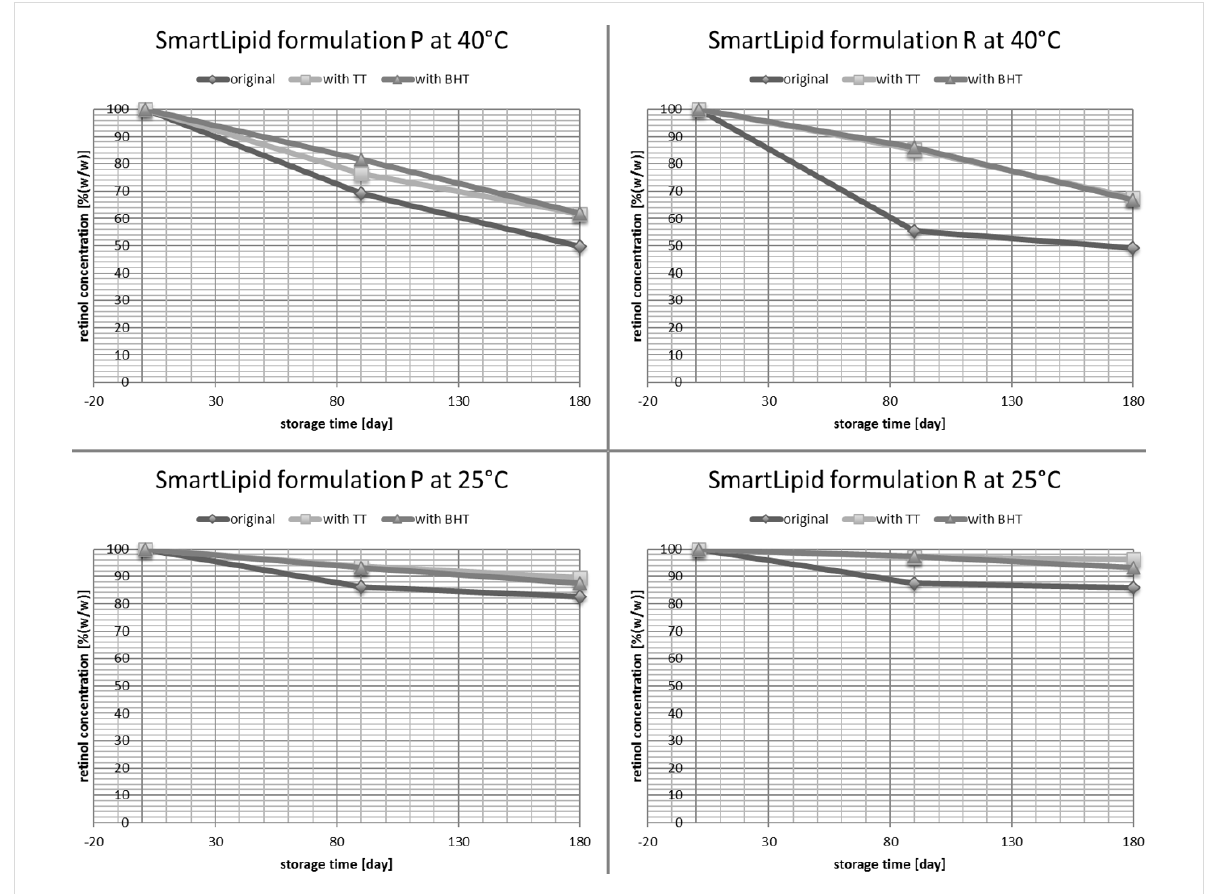
Figure 5: Storage study with retinol loaded SmartLipids particles over six months. Remaining retinol content in SmartLipids formulation P (left) and R (right) before and after incorporation of lipophilic antioxidants Tinogard TT and BHT at 40°C (upper) and room temperature (25°C, lower), [10].